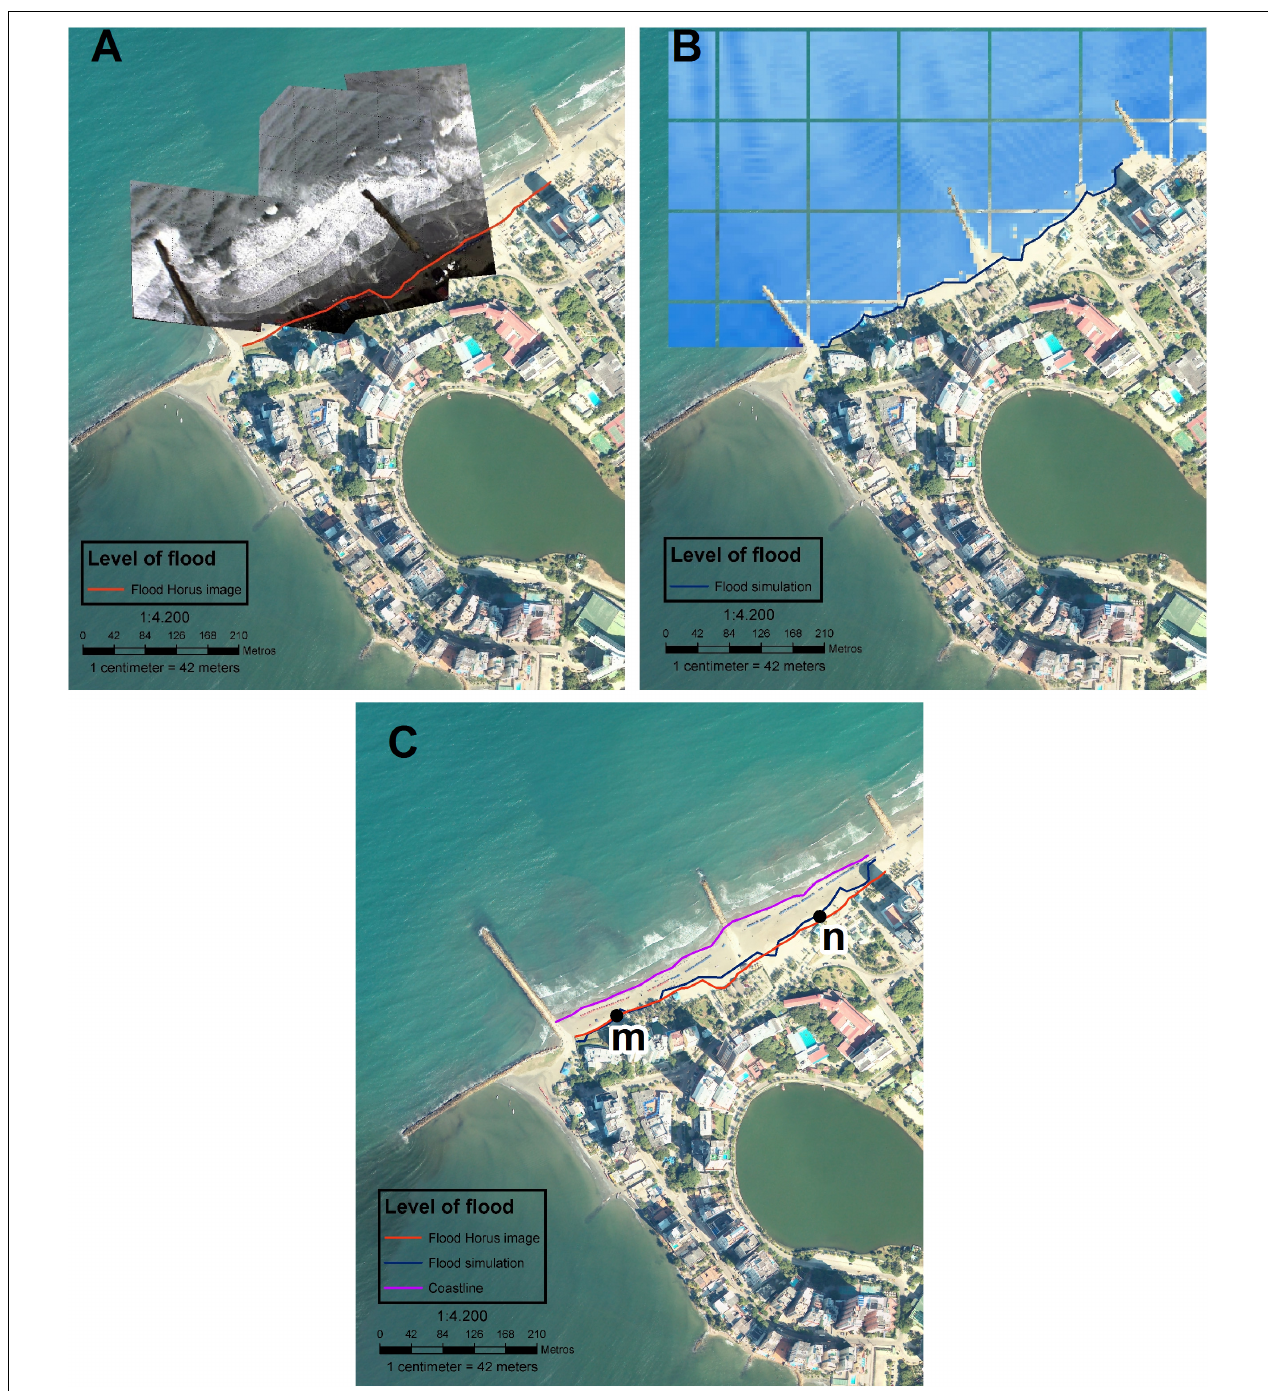
FIGURE 6 | Run-up in Bocagrande beach during the passage of a cold front in November 8th, 2010: (A) As recorded by HORUS camera system (red line), (B) simulated with SWASH (blue line), and (C) comparison between simulated and recorded run up. The magenta line represents the coastline.